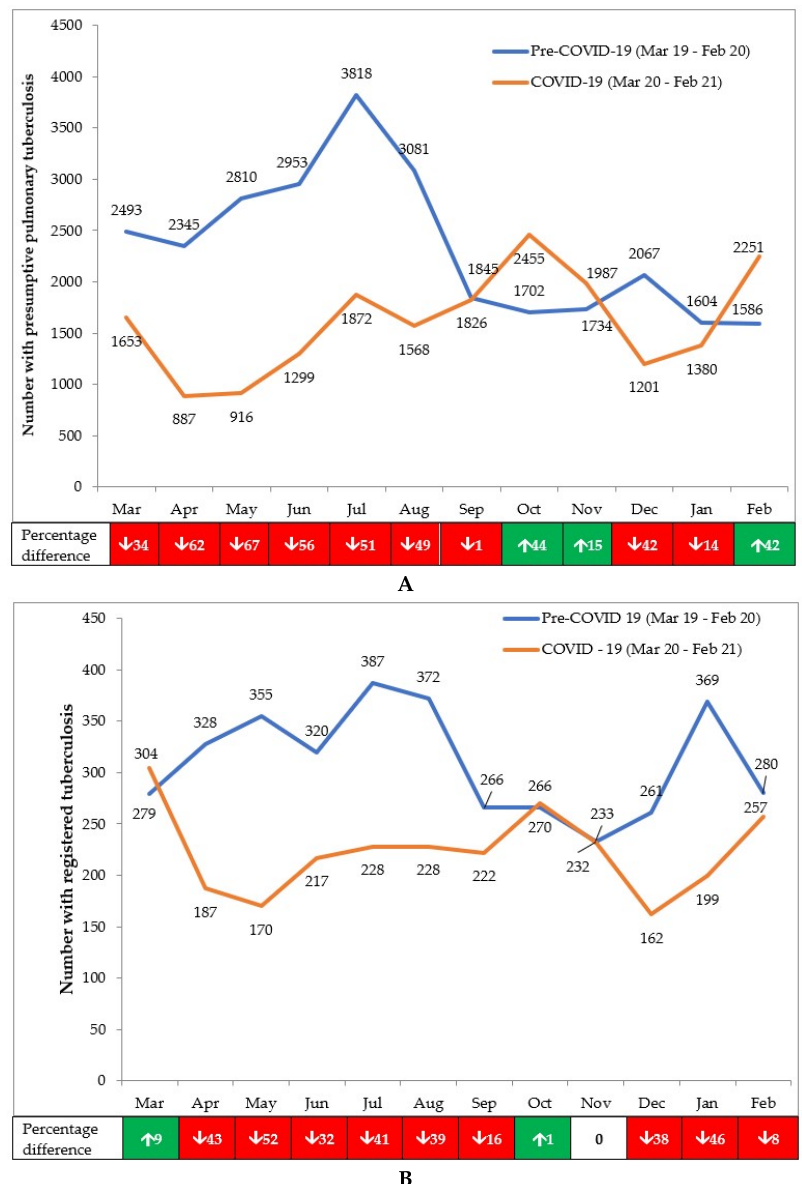
Interventions applied from August 2020 onwards to counteract the decline in numbers included: (i) integrated screening and fast-tracking of investigations for TB and COVID-19 in patients presenting with respiratory symptoms; (ii) active TB case finding in hot spots in the city; (iii) enhanced TB case finding that included screening of TB through mobile phones using a dedicated USSD dialing code, asking patients to dial into a toll-free TB screening call center staffed by healthcare workers and use of automated TB screening machines positioned at strategic spots in the community; (iv) active trac- ing of close contacts of index patients; and (v) improved TB screening among people living with HIV. Figure 2. ( A ) Numbers presenting each month with presumptive PTB in 18 health facilities in Nairobi, Kenya, during pre-COVID-19 and COVID-19 periods ( B ) Numbers presenting each month with registered TB in 18 health facilities in Nairobi, Kenya, during pre-COVID-19 and COVID-19 periods.